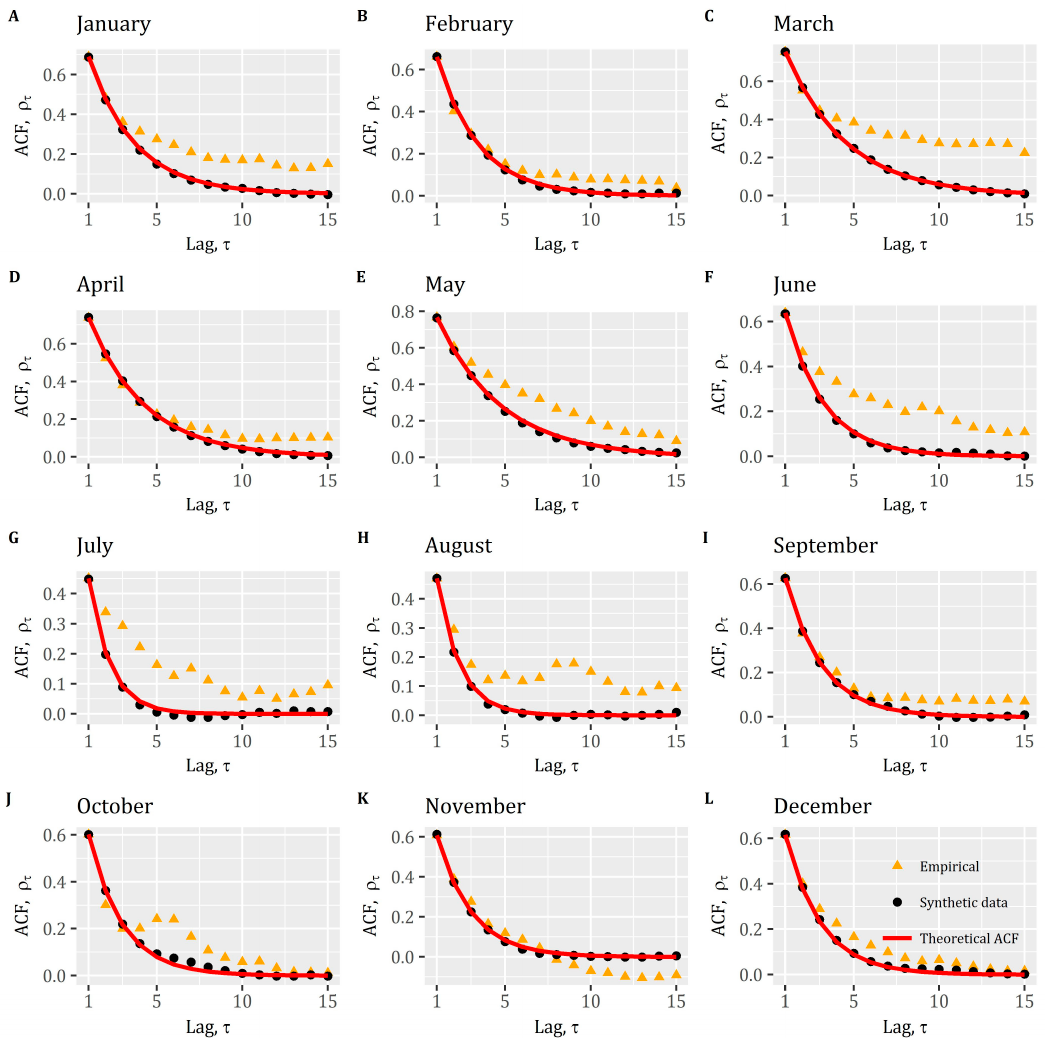
Figure A2. Monthly-based comparison of empirical (historical), synthetic (using AR(1) with P III white noise), and theoretical autocorrelation functions (ACFs) of the real-world case study employed in Section 3—“Real-world case study” of the main manuscript.